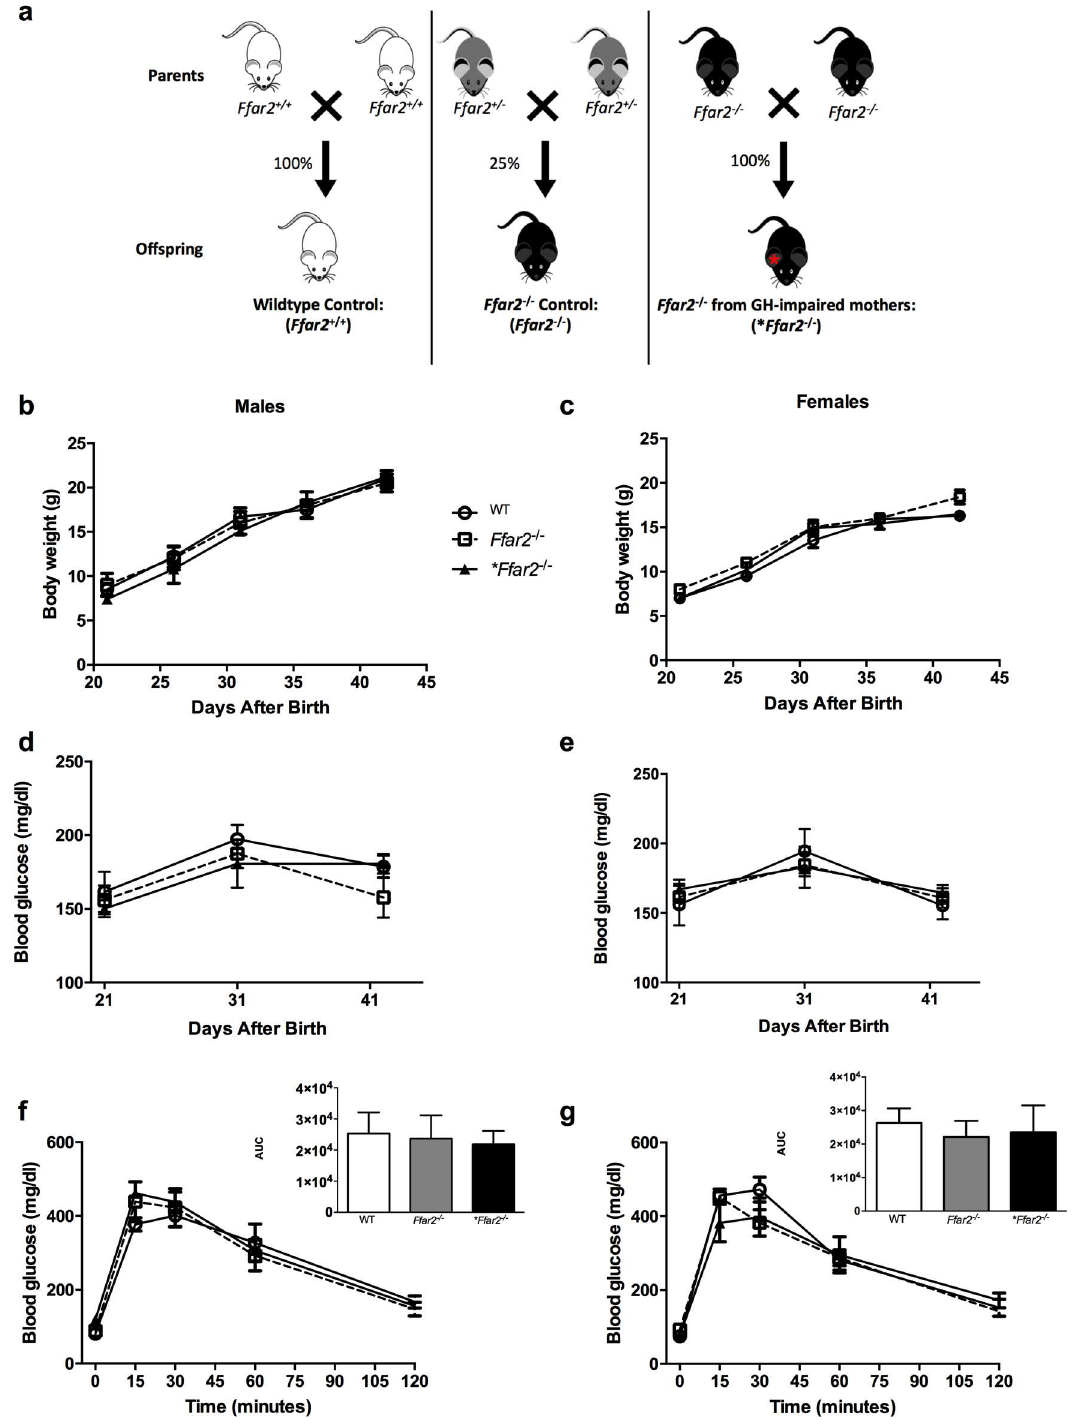
Fig 2. WT , Ffar2 -/- and * Ffar2 -/- mice exhibit similar weight gain, random glucose levels and glucose tolerance at 6 weeks of age. ( a ) Breedingscheme to generatethese offspring is shown. For b-g , changesin body weight ( b-c ), ad lib plasma glucoseconcentrations ( d-e ) and plasma glucoseconcentrations duringan IPGTT ( f-g ) with male ( b, d and f ) and female ( c, e and g ) WT , Ffar2 -/- and * Ffar2 -/- offspring are shown. Inserts for f and g represent the area under the curve for the IPGTT. WT, circles and white bars; Ffar2 -/- , squaresand gray bars; * Ffar2 -/- , trianglesand black bars. Data are represented as mean ± SEM ( * p (cid:20) 0.05), n = 3–12. Data in (b-g) were compared by 2-way ANOVA with Bonferronipost- hoc